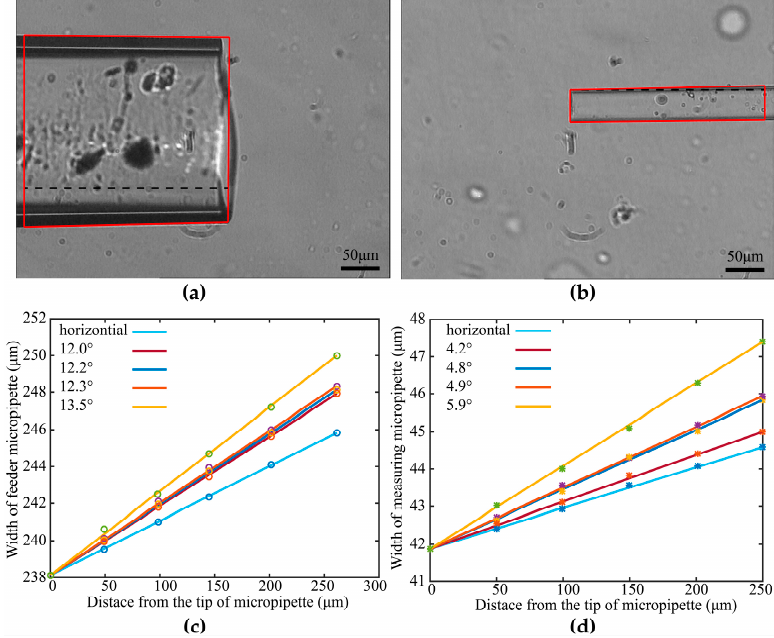
Figure 5. Tilt angle detection results. ( a ) A tilted feeder micropipette (FM). ( b ) A